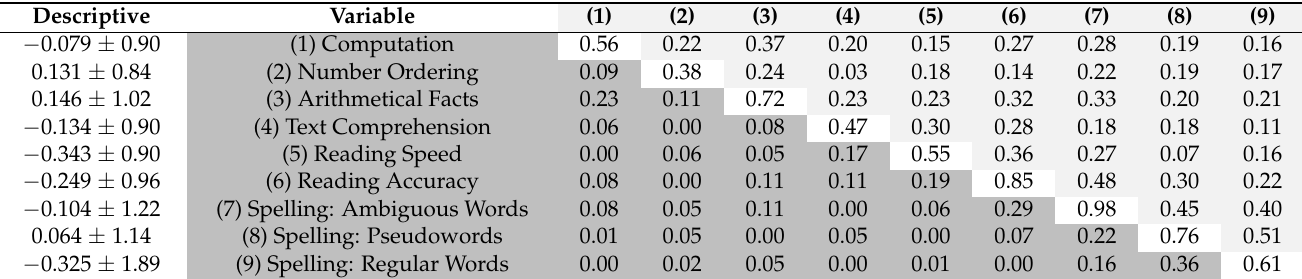
Table 2. The lower part (dark background) reports the network weights, which correspond to regularised partial correlations. The upper part (light background) reports simple correlations, measured with Pearson’s r. The diagonal reports the strength centrality index. The first column reports the mean z scores ± the standard deviations.